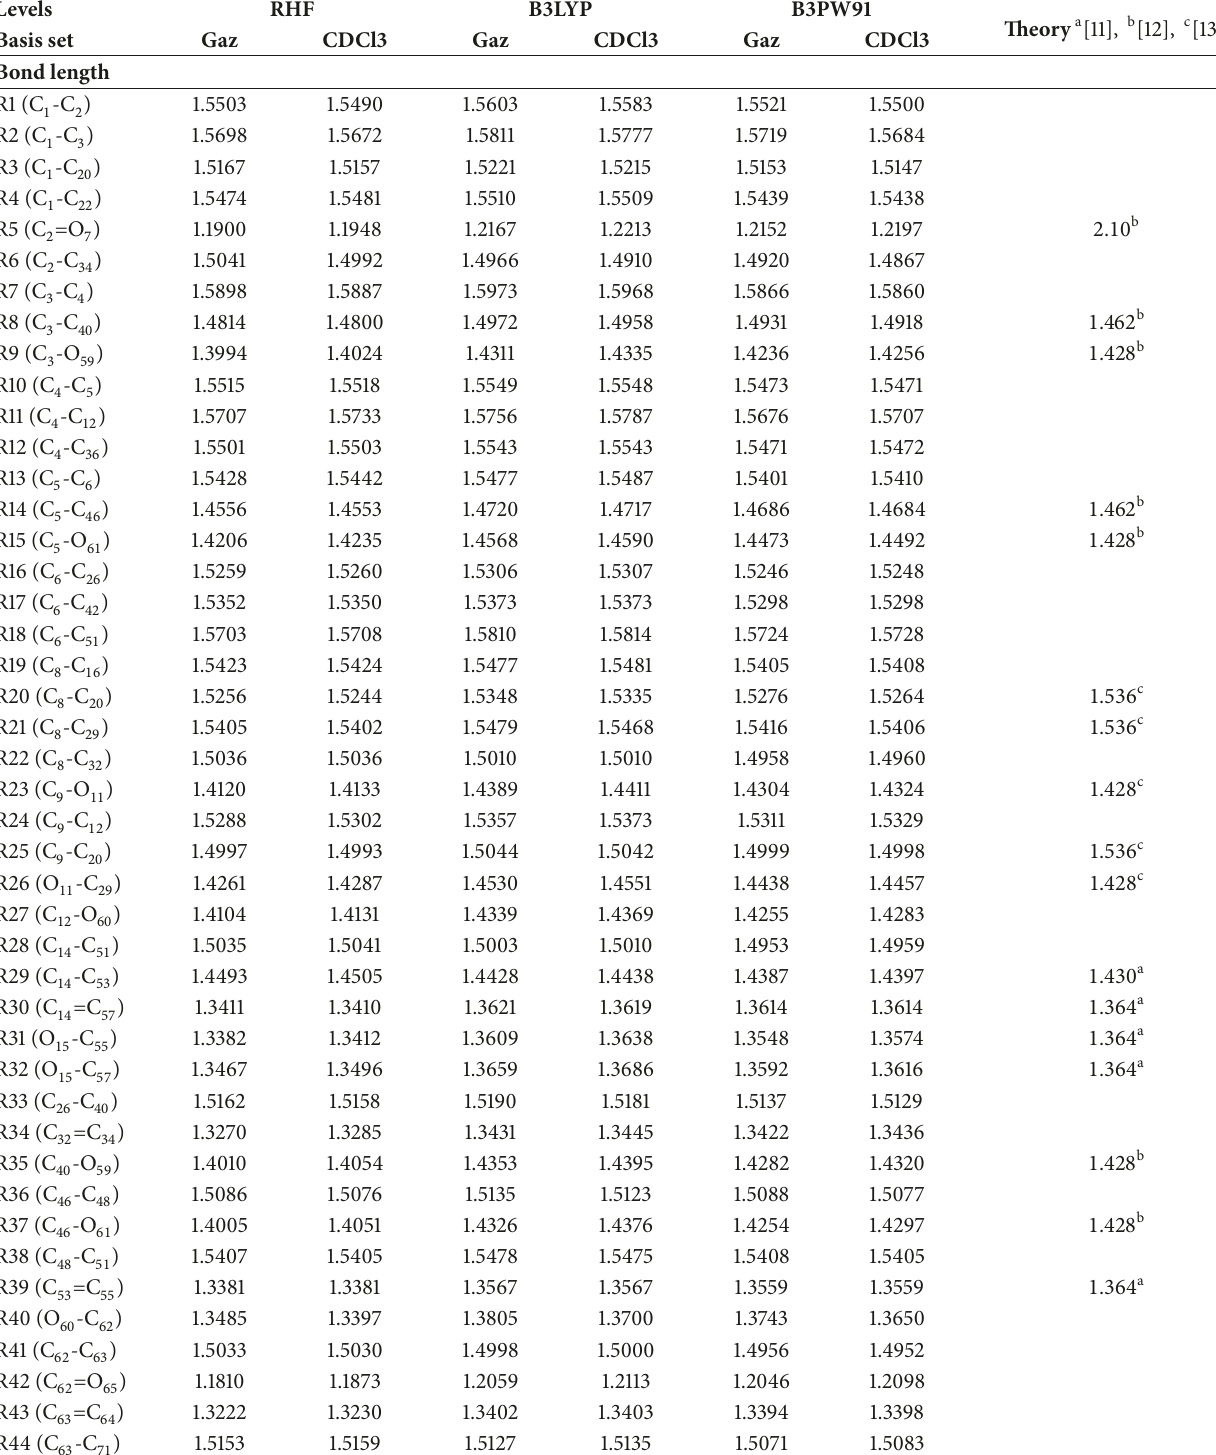
Table 1: Optimized geometric parameters in gas phase and in chloroform solution of Rubescin E at the RHF, B3LYP, and B3PW91 level with the 6-311++G (d,p) basis